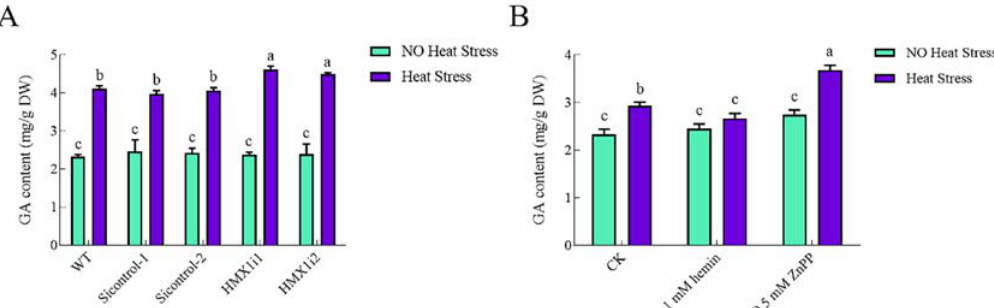
Figure 3. Effects of HO on GA content under heat stress. ( A ) GA content of HMX1 silenced strains was significantly higher than that of WT strain under heat stress. ( B ) Exogenously adding 1 mM hemin did not affect GA content; in other words, the increasing trend of GA content under heat stress compared with non-heat stress was suppressed. In contrast, the content of GA was significantly increased in WT strain treated with 0.5 mM exogenous ZnPP under heat stress. All calculated results are expressed as mean ± standard deviation, and these English letters of “a”, “b” and “c” are indicated significant differences among different treatments ( p < 0.05).